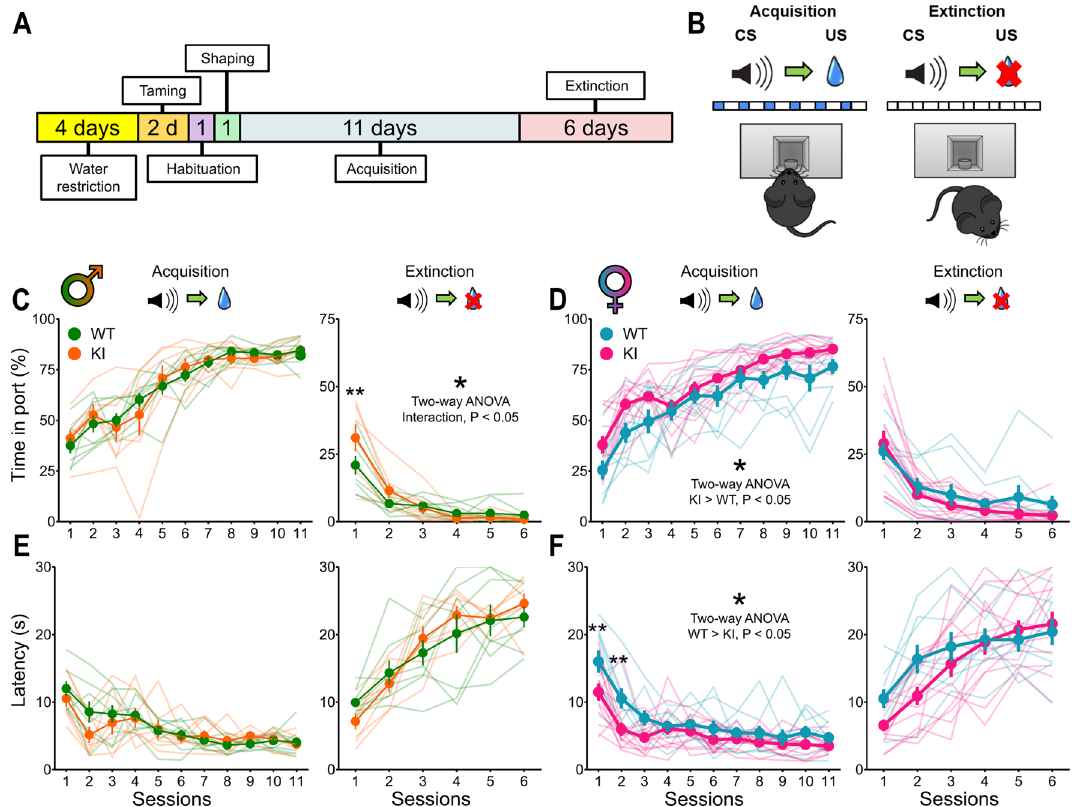
Figure 2. DAT-Cre KI mice have sex-dependent alterations in reinforcement learning. ( A ) Timeline of reinforcement learning experiment. ( B ) Cartoon of outcome contingencies and expected behaviors in the task. During acquisition, an auditory cue signals the availability of water reward, that is delivered in cycles as long as the mouse keeps its head in the port. In extinction, the same cue is presented, but no water is delivered. ( C , E ) Time in port ( C ) and latency to respond ( E ) during the acquisition and extinction of a conditioned response in male KI and WT mice. Male KI mice were comparable to controls during acquisition, but were slower to extinguish responding, as measured by the time in port measure. ( D , F ) Same as ( C ) and ( E ), but for female mice. Female KI mice, in contrast to males, were similar to controls during extinction, but responded more and faster to the cues throughout the entire acquisition phase, especially in the initial sessions, as was better revealed in the latency measure. Asterisks atop individual data points indicate multiple comparison results between groups. * P < 0.05; ** P <